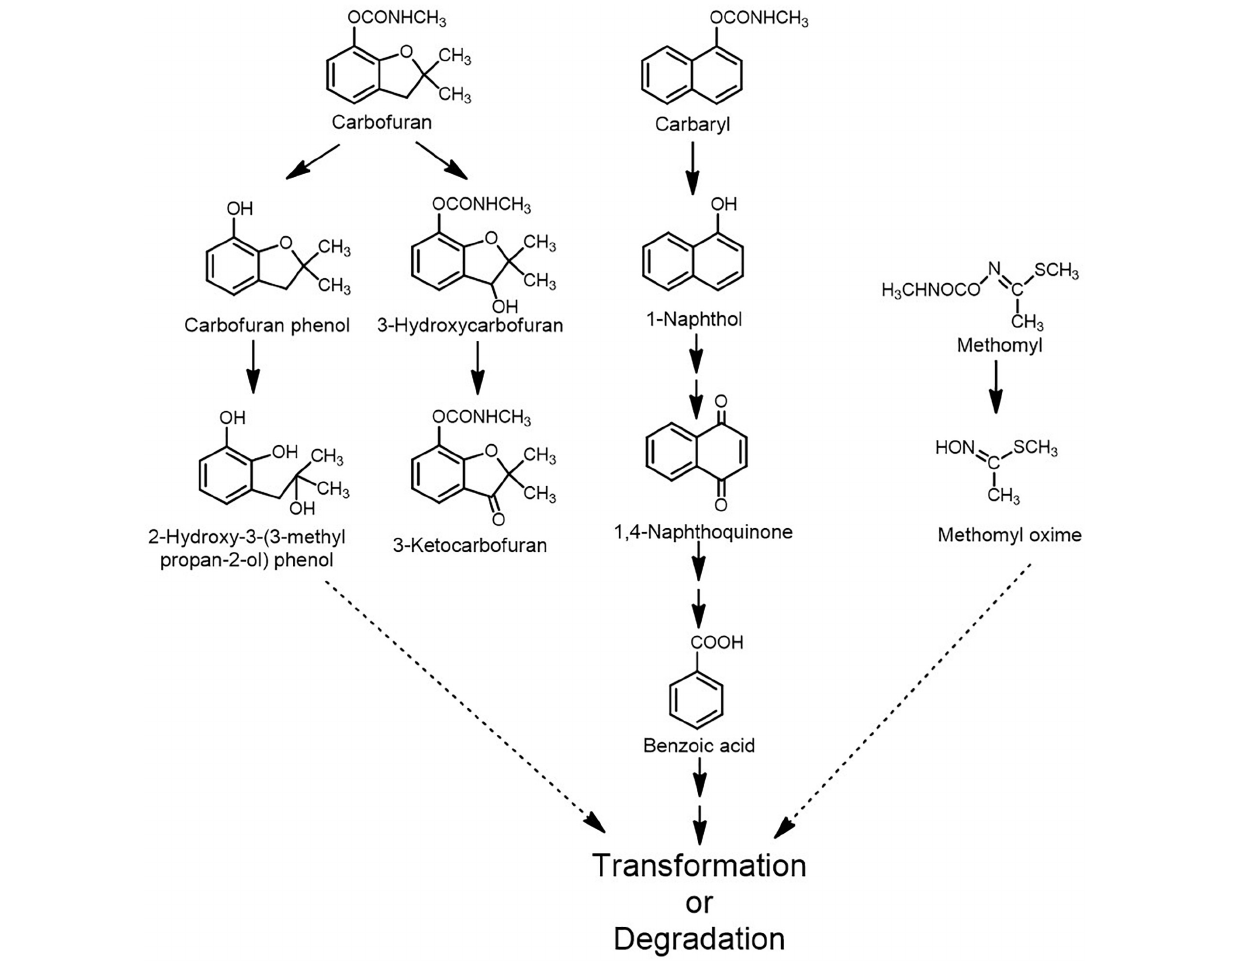
FIGURE 8 | Metabolism/transformation of various carbamate pesticides by